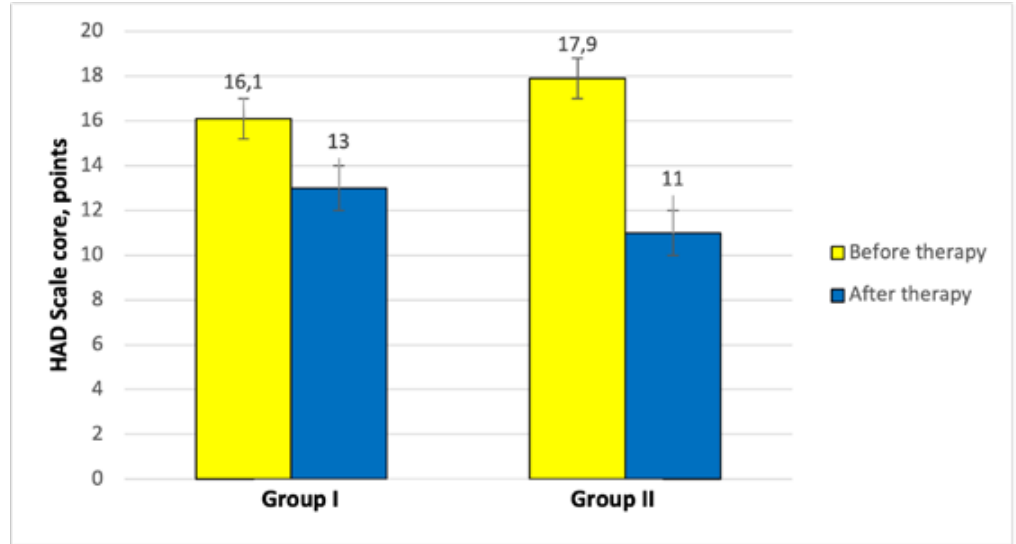
Figure 1. Changes in the HAD scale between group I subjects treated with physiotherapy and group II subjects treated with dance and movement therapy. Statistical significance * p <